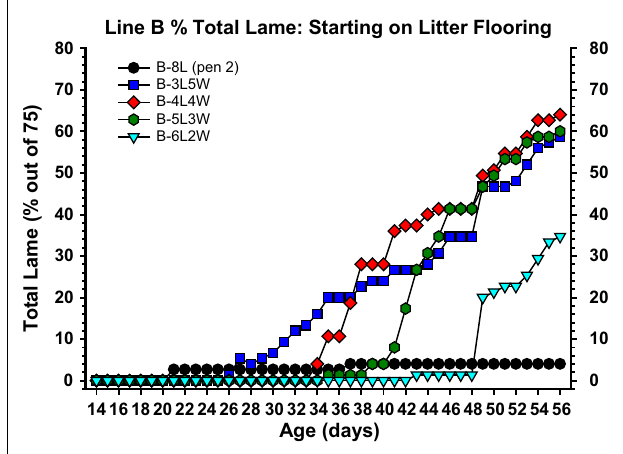
FIGURE 7 | Cumulative incidence of total lameness for broilers that at 1day of age were placed on clean wood shavings floor litter (L), and either remained on litter for 8weeks (8L) or were transferred from litter to flat wire flooring (W) for the remainder of the 8-week experiment, beginning at 3weeks of age (3L5W), 4weeks of age (4L4W), 5weeks of age (5L3W), or 6weeks of age (6L2W). All birds were pushed to grow as rapidly as possible to meet their genetic potential (23h of light per day, high density feeds provided ad libitum , thermoneutral and well ventilated environmental conditions).The incidence of lameness remained typically low as long as the broilers remained on litter, however within 5–7days after being transferred to wire flooring the incidence of lameness increased dramatically.Total lameness for the 3L5W, 4L4W, and 5L3W groups converged to between 59 and 64% by week